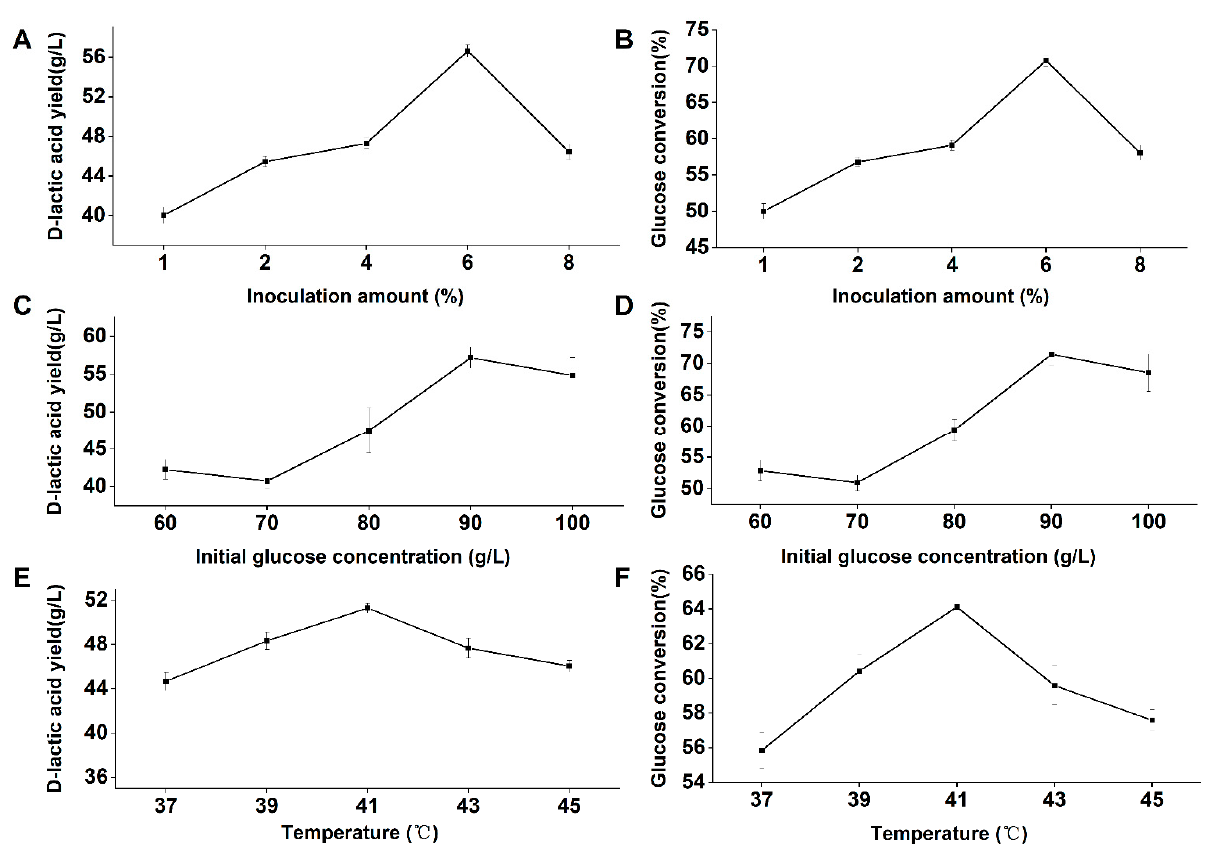
Figure 2. Fermentation conditions for D -lactic acid production by immobilized T15 cells ( A ) The effect of inoculation amount on D-LA yield; ( B ) The effect of inoculation amount on glucose conversion; ( C ) The effect of initial glucose concentration on D-LA yield; ( D ) The effect of initial glucose concentration on glucose conversion; ( E ) The effect of temperature on D-LA yield; ( F ) The effect of temperature on glucose conversion).